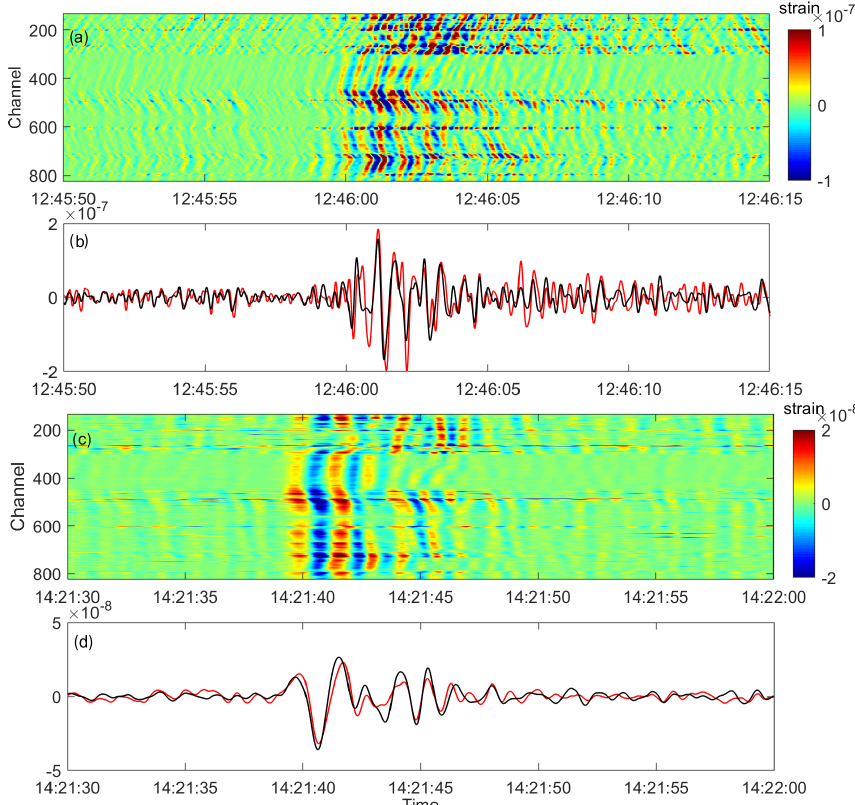
Figure 2. Time series of DAS strain during a small volcanic explosion (VE) at Etna on 6 July 2019 (a, b) and during a long-period (LP) event on 27 August 2019 (c, d) . The DAS strain is computed by integrating the DAS records over time. Data are filtered in the frequency range 1 to 5Hz for the VE event (a, b) and between 0.1 and 1Hz for the LP event (c, d) . (b, c) The broadband velocity at station Bb04 (black line in b and d ), located in proximity of the DAS channel 501 (red line in b and d ), is projected along the cable direction to compare the data using the single-station procedure. An average scaling factor of 1skm − 1 for the slowness value is found in both